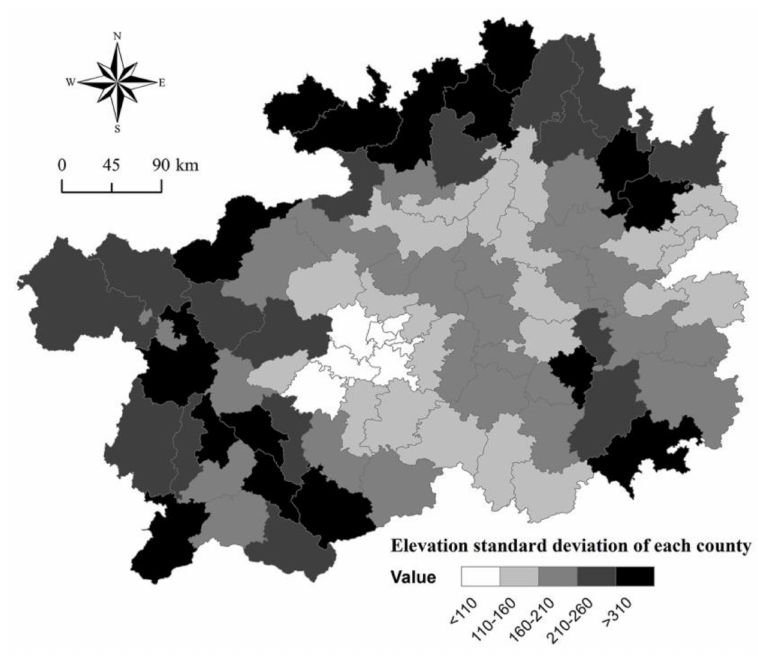
Figure 7. Distribution of elevation standard deviation at the county level.